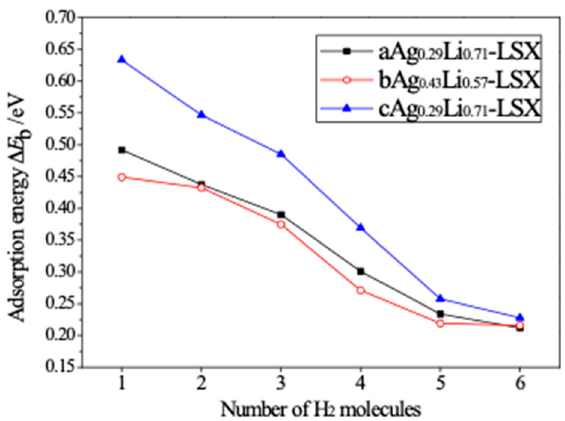
Figure 9. Adsorption binding energy of multiple H 2 molecules around Ag cations for aAg 0.29 Li 0.71 -LSX, bAg 0.43 Li 0.57 -LSX and cAg 0.29 Li 0.71 -LSX, varying with the number of H 2 molecules binding around one cation.